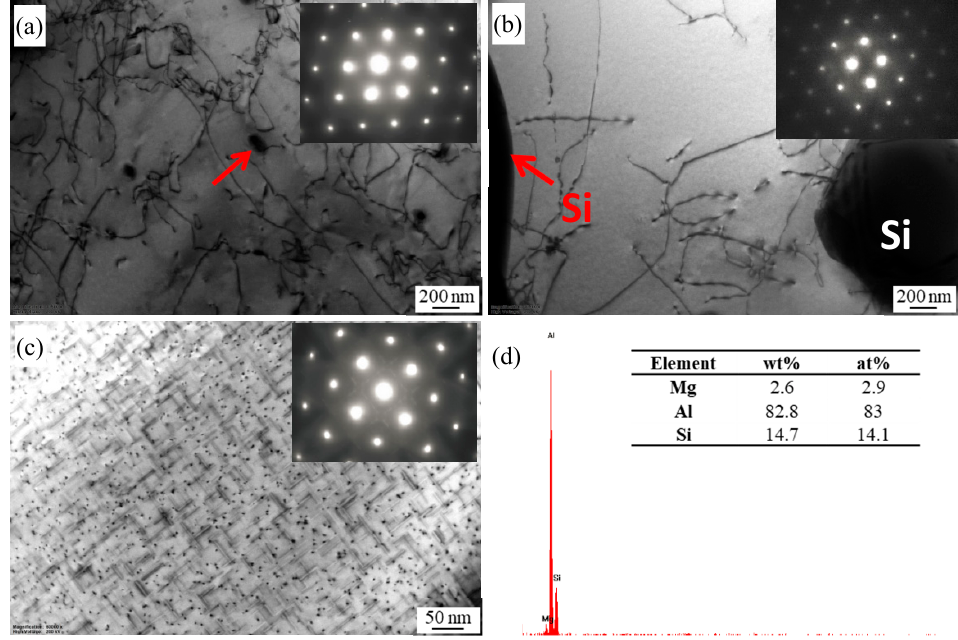
Figure 3. TEM images of BMs with different heat treatment states: ( a ) T1; ( b ) T4; ( c ) T6; ( d ) corresponding EDS point analysis taken from the arrowed second phases in (a).